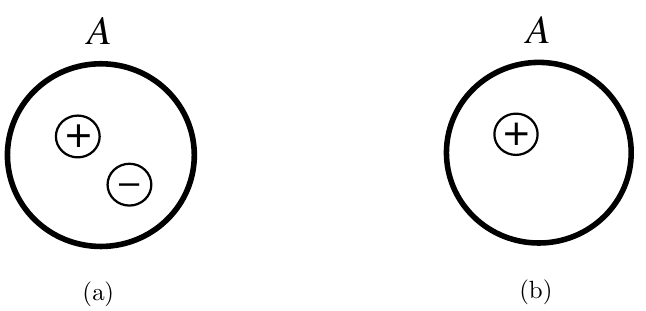
Figure 1. (a) A charge neutral operator in region A : a 2 A A . (b) A charged operator in region A : b 2 F A